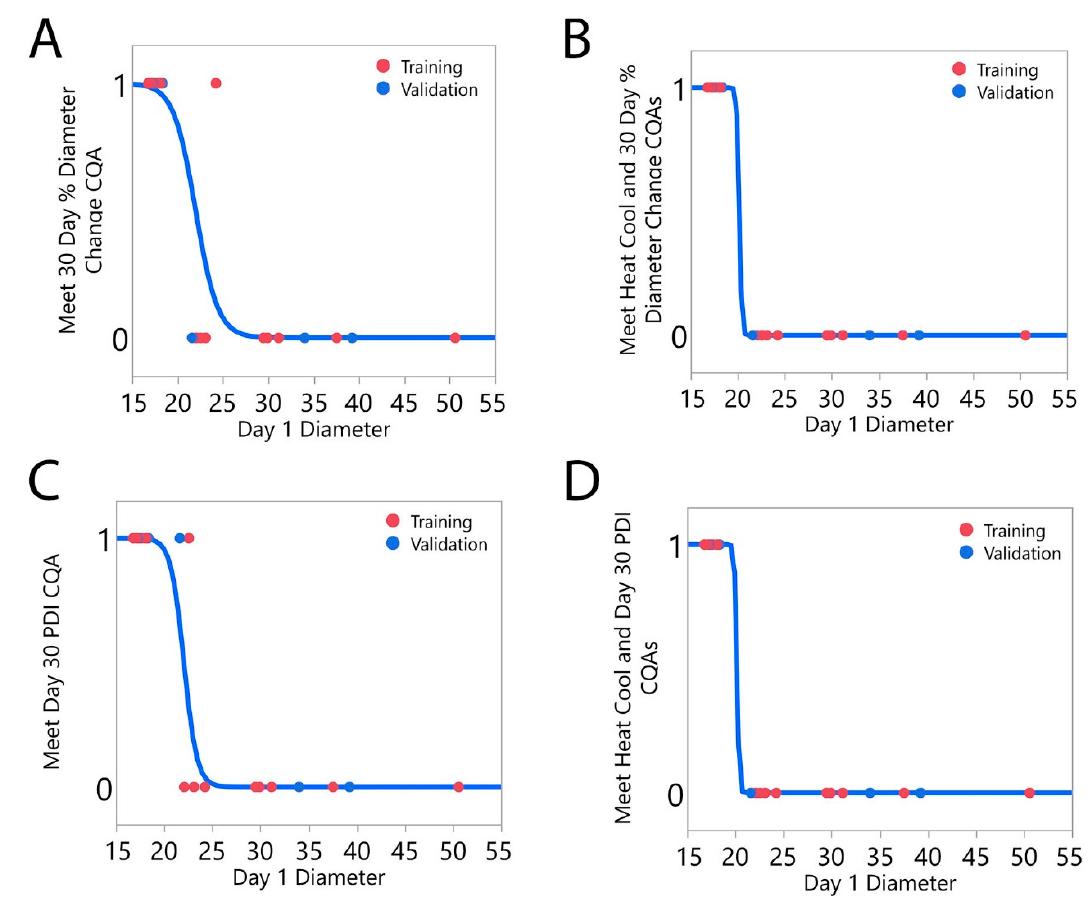
Figure 2. Logistic regression models predict the probability that a microemulsion will meet one or more CQA specifications-based upon its day 1 diameter measurement. ( A ) 30-day percent diameter change; ( B ) 30-day percent diameter change and thermal cycling percent diameter change; ( C ) day 30 PDI; ( D ) day 30 PDI and thermal cycling PDI. The predictive accuracy of the logistic models improves when two CQA specifications must be met. Table 10. Confusion tables for the logistic models that use day 1 microemulsion diameter to predict whether a microemulsion will meet the CQA specifications of thermal cycling diameter change and 30 ‐ day diameter change.